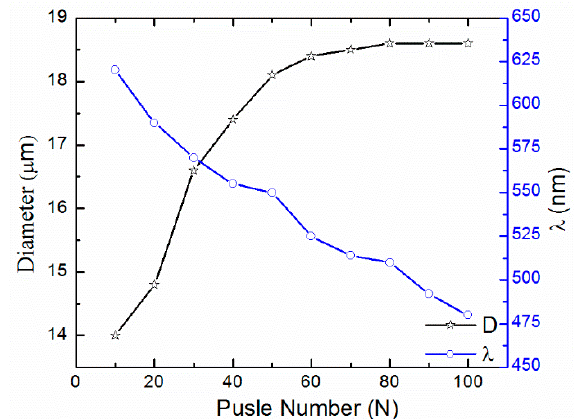
Figure 3. Dimensions and periods of multiple-shot ablated regions with subwavelength ripples as a function of pulse number. The laser pulse energy is 0.20 J/cm 2 in all cases.